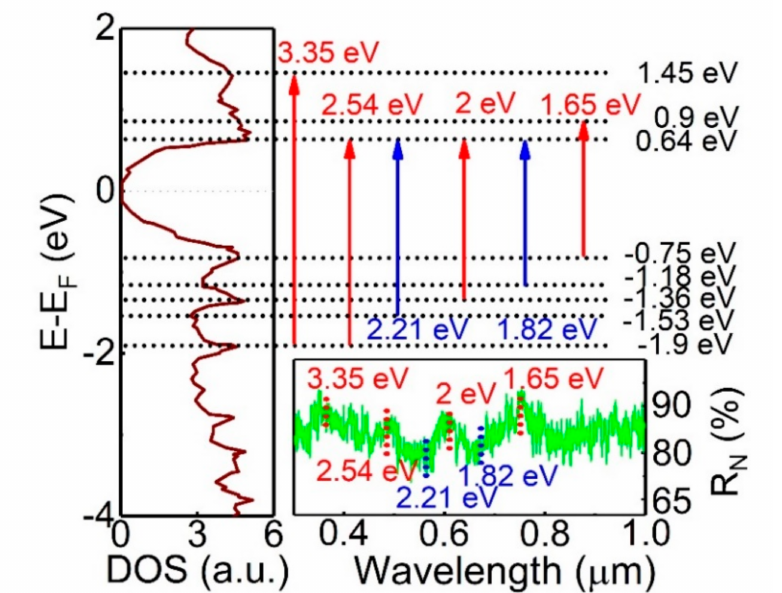
Figure 5. The left side shows the band structure of the Sb 2 Te 3 bulk state. The right side shows the photocurrent as a function of light wavelength. The corresponding energies of these photocurrent peaks at different light wavelengths are consistent with the energy difference of band structure peaks between conduction and valence